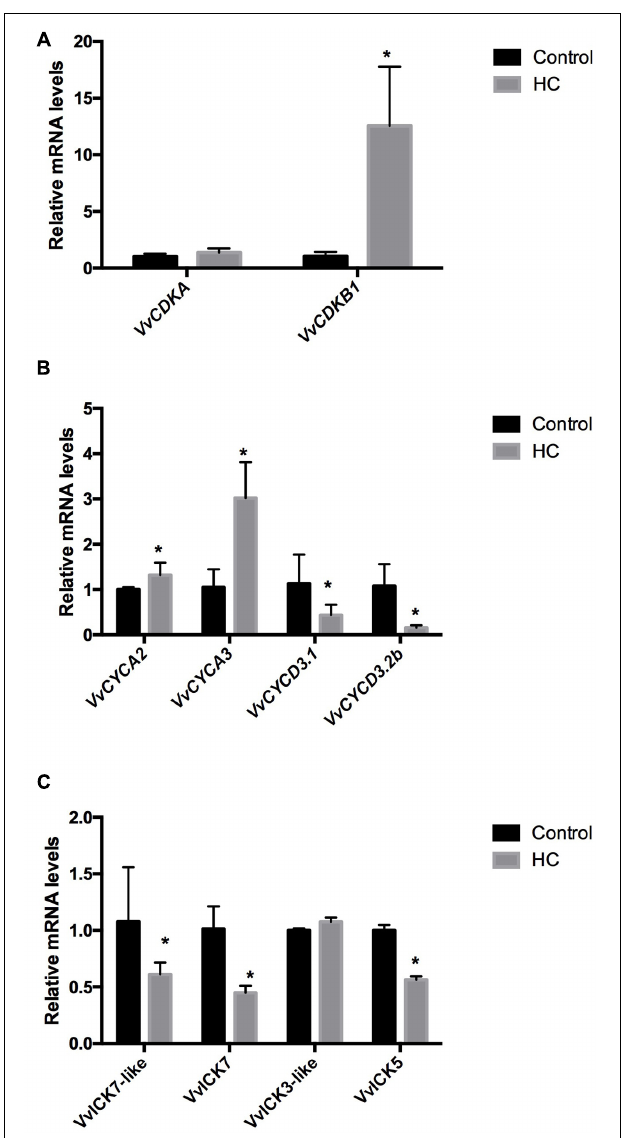
FIGURE 6 | Effect of HC on the expression of (A) cyclin-dependent kinases ( VvCDKs ), (B) cyclins ( VvCYCs ), and (C) inhibitors of CDKs ( VvICKs ) in Thompson seedless grapevine buds. Gene expression analysis was performed by RT-qPCR and normalized against VvUBIQUITIN . Values are the average of three biological replicates with three technical repetitions ± SD; (asterisk) Student’s t -test ( α =